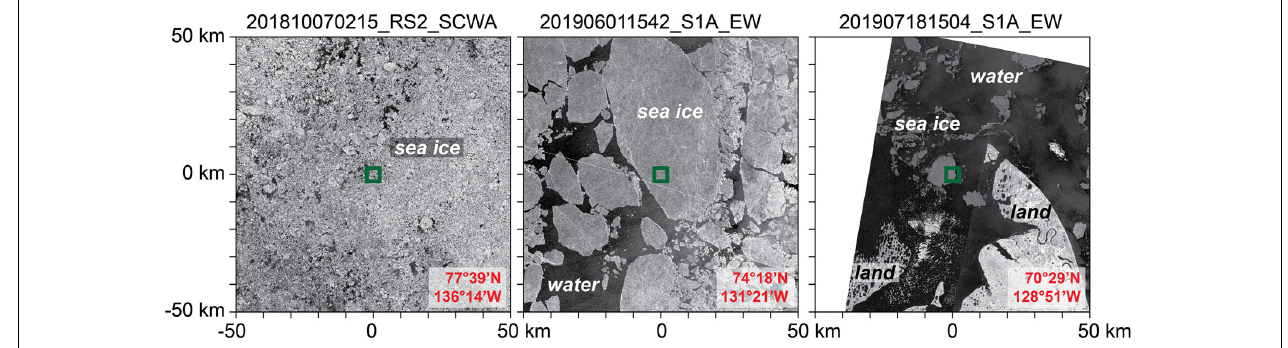
FIGURE 9 | Ice conditions shortly after deployment of WIMBO1 (20181007) and in the following spring (20190601) and summer (20190718) as it drifted 100 s of kilometers south. The floe chosen for WIMBO1 deployment was one of the last floes to melt near the Canadian coast. Bottom row shows 100-m resolution SAR images in a 100-km box centered on WIMBO1 (green box) from October 07, 2018, June 01, 2019, and July 18, 2019. Cape Bathurst is apparent in the last SAR